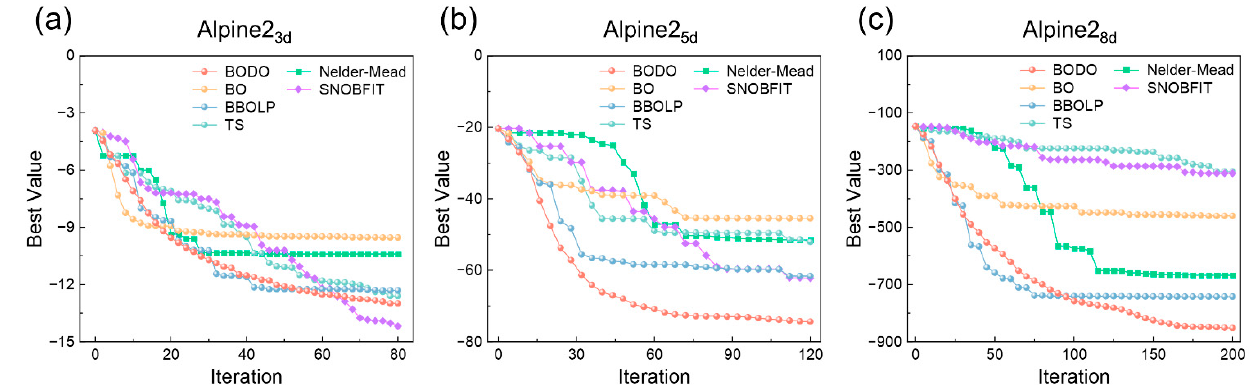
Figure 6. Average optimization results of BODO ( ε 1 = 0.6, ε 2 = 0.4, β = 1) and comparing algorithms on ( a ) alpine2 3d , ( b ) alpine2 5d , and ( c ) alpine2 8d test functions. Their theoretical minimal values are − 17.21, − 135.73, and − 3005.58, respectively. Algorithms are run for 80, 120, and 200 iterations on alpine2 3d , alpine2 5d , and alpine2 8d , respectively. The average results are obtained from 10 random initial point sets which are set the same for all algorithms. Non-deterministic methods (BODO, TS, and SNOBFIT) are run for 10 times on each initial point set and then the results are averaged. The batch size of BBOLP is set to 5.